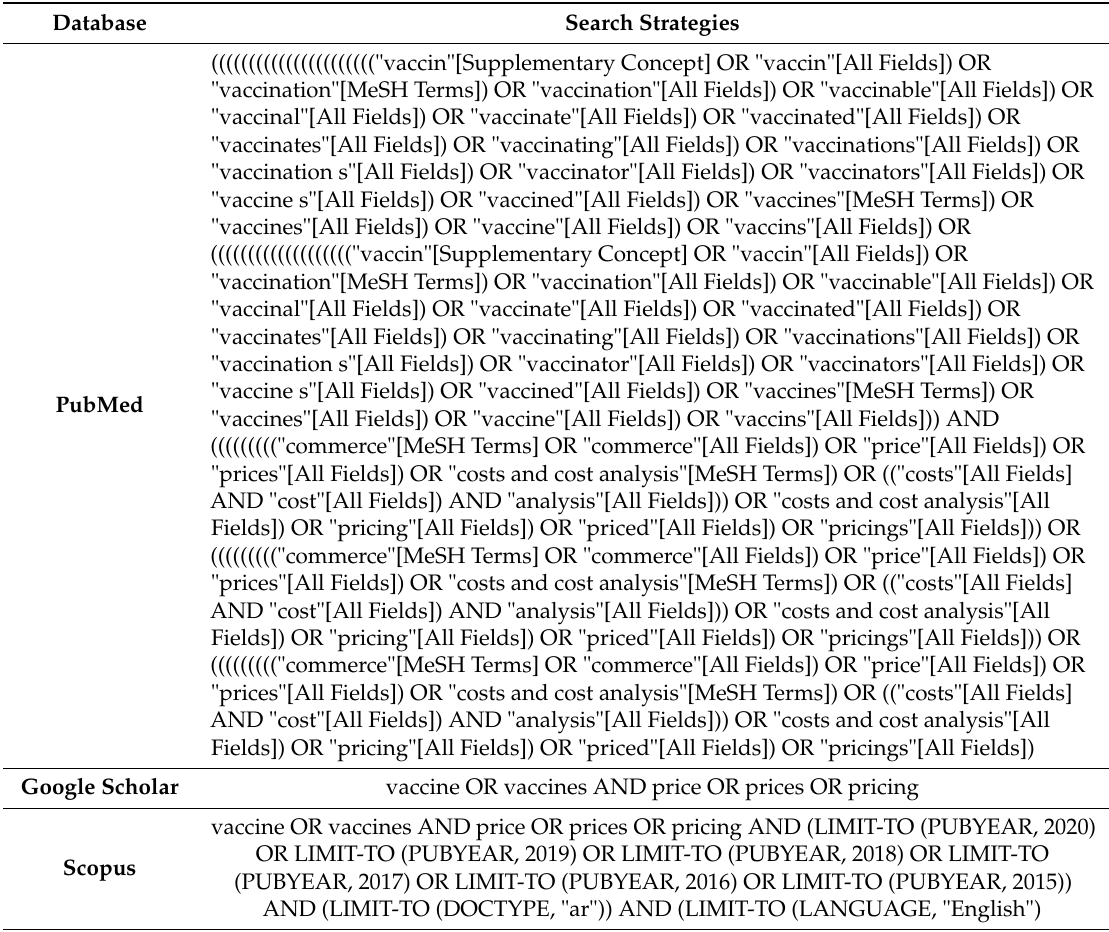
Table 1. Databases and keywords used in search